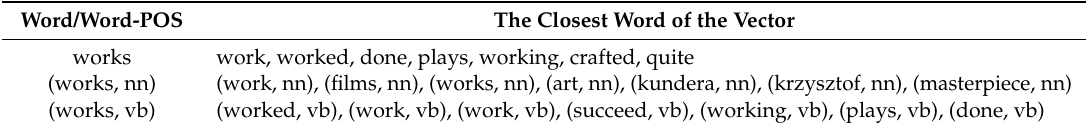
Table 1. The comparison between traditional word embedding model and the Word-Part-of-Speech (POS) model regarding similar elements.